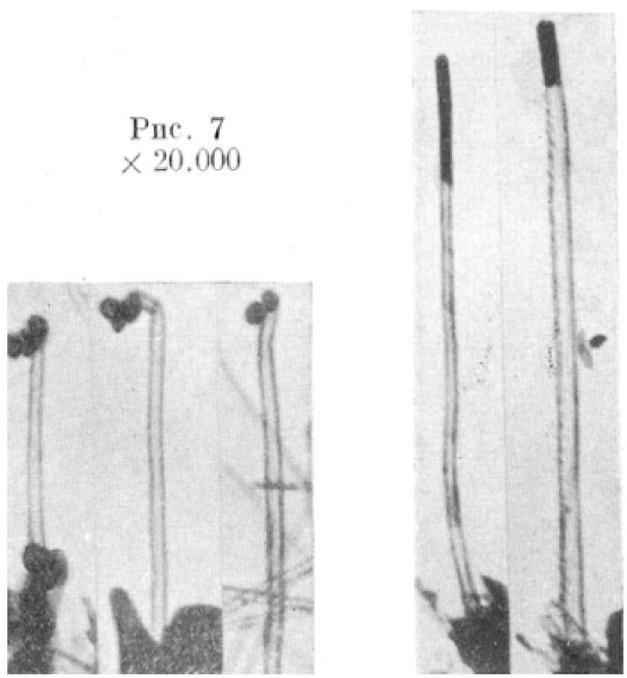
Figure 1. Very early transmission electron microscopy images of hollow carbon filaments. Reproduced with permission from [22]. Nauka Publishers, 1952.